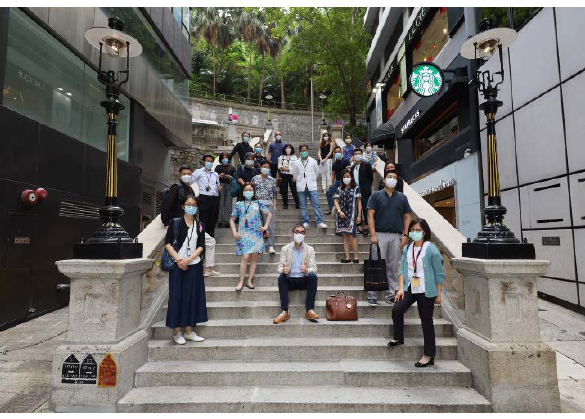
Figure 13: CHO and AAB members visited the Steps after restoration works completed.